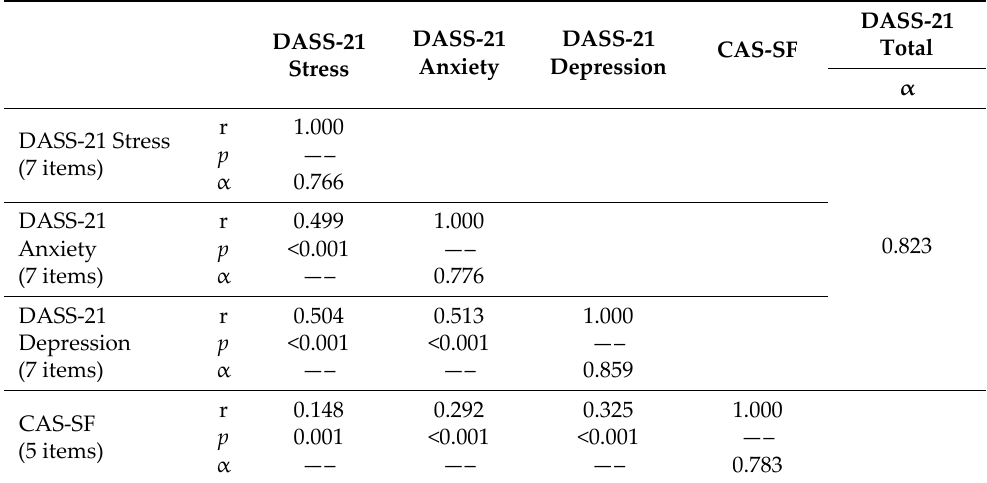
Table 5. The results of the reliability analyses and correlations of the